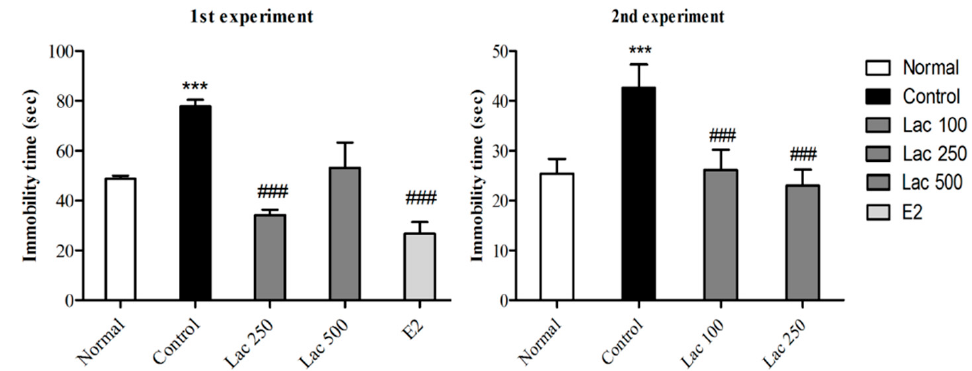
Figure 3. Oral lactate administration reduced immobility time in FST following ovariectomy and repeated stress. One-way ANOVA comparisons revealed a remarkable decrease in the time spent immobile in forced swimming tests in lactate treated groups (100 and 250) and the estradiol group compared to control rats. Values are presented as mean ± SEM. *** show differences between the normal and control groups. ### show significant differences between the control group and treatment groups. *** and ### p < 0.001. The p -value of the test was <0.001 by one-way ANOVA, followed by a post hoc LSD test.